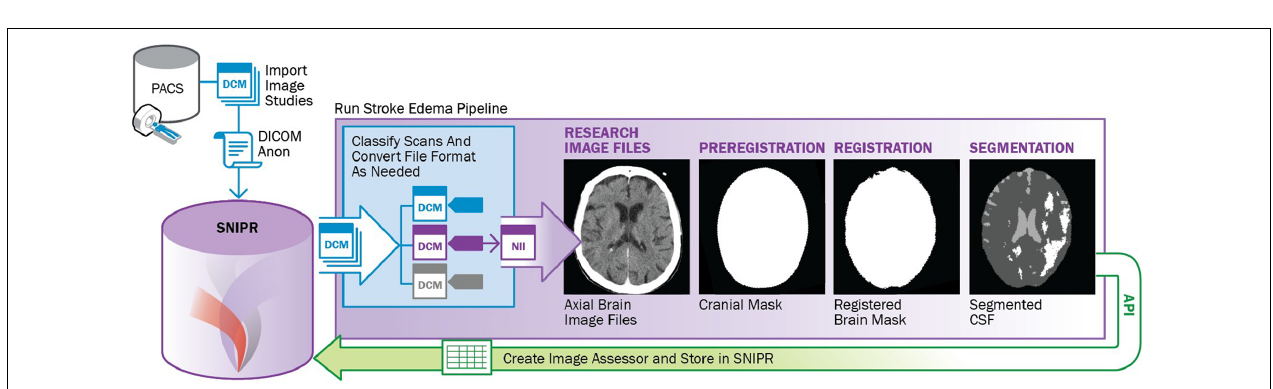
FIGURE 4 | Outline of stroke edema image processing pipeline to analyze CSF volumes from large cohorts of stroke patients.